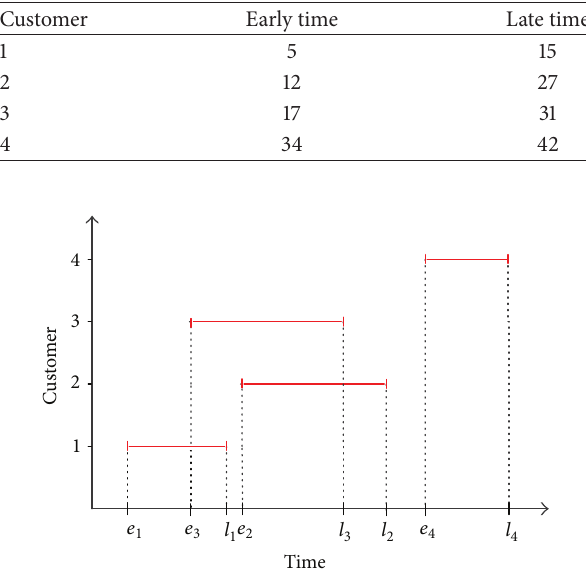
Figure 3: Time windows for the sample